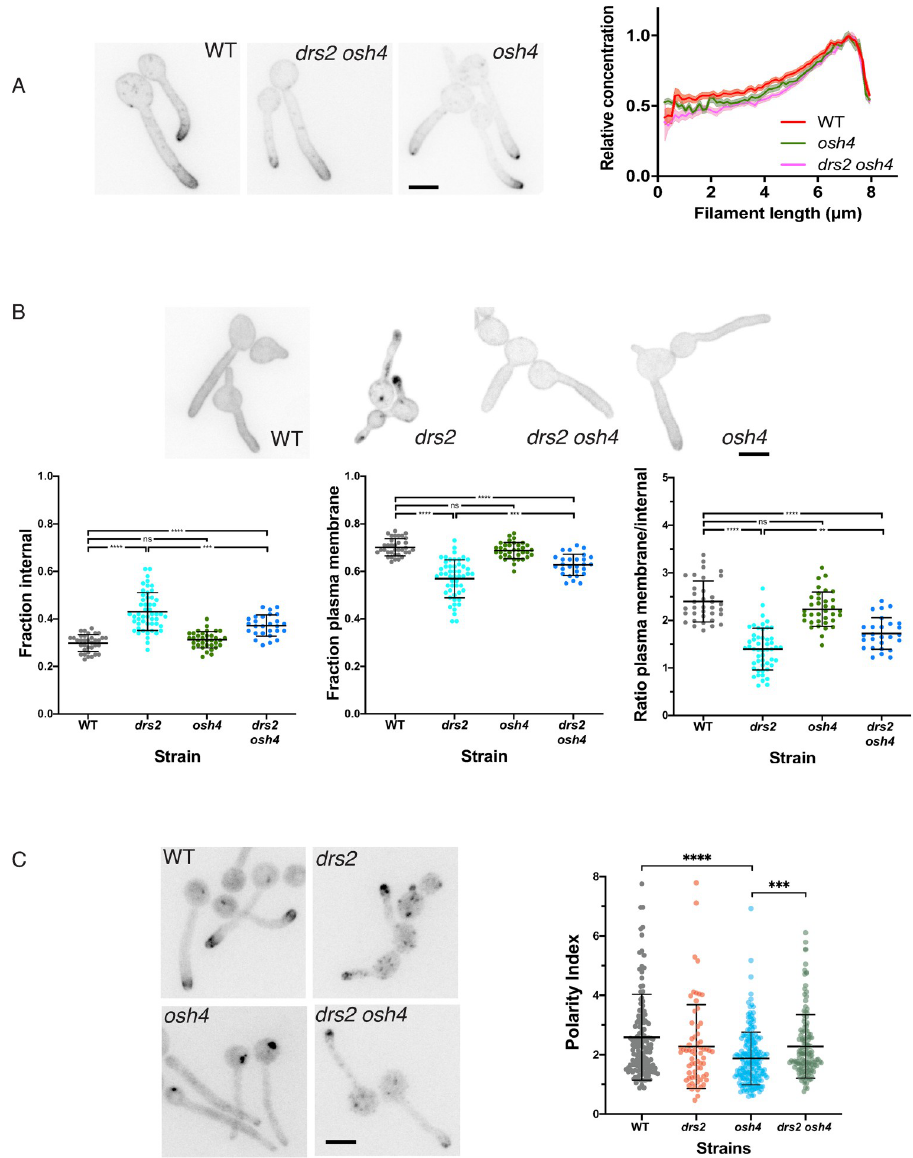
Fig 9. Deletion of OSH4 rescues PI(4)P distribution in the drs2 mutant. A) PI(4)P distribution is restored in the drs2 mutant upon OSH4 deletion. Indicated cells expressing GFP-(PH OSH2[H340R] ) 2 -GFP, WT (PY5619), drs2/drs2 osh4/osh4 ( drs2 osh4 , PY5630) and osh4/osh4 ( osh4 , PY5626) were incubated as in Fig 6B, with sum projections of representative cells shown. The graph illustrates the means ± the SEM of the relative concentration of PM PI(4)P as a function of filament length, normalized to the maximal signal for each cell ( n = 100 cells). B) PS distribution is partially restored in the drs2 mutant upon OSH4 deletion. Indicated cells expressing GFP-LactC2, WT (PY3239), drs2/drs2 ( drs2 , PY5134), drs2/drs2 osh4/osh4 ( drs2 osh4 , PY5364) and osh4/osh4 ( osh4 , PY5336) were incubated as in Fig 6B, with sum projections of representative cells shown. The graphs represent the relative PM and internal PS fractions, as well as the ratio of the signal at the PM over the internal signal for the indicated strains ( n = 30–50 cells each), and bars mean ± the SD. ���� , P < 0.0001; ��� , P < 0.001; �� , P < 0.01; ns, not significant. C) OSH4 deletion does not substantially restore ergosterol distribution in the drs2 mutant. Images of the indicated strains expressing mScarlet- D4H, WT (PY6037), drs2/drs2 osh4/osh4 ( drs2 osh4 , PY6286) and osh4/osh4 ( osh4 , PY6076) were taken as in Fig 7B. The graph represents the ergosterol tip polarization, i . e . the ratio of apical to sub-apical D4H signals, in the indicated strains.